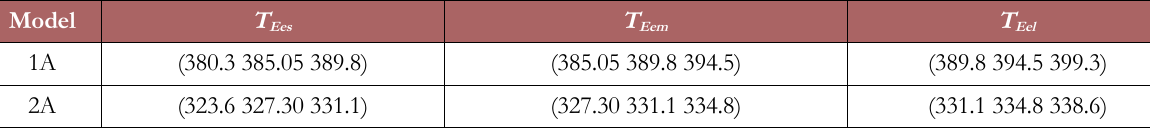
for two bicycle models Ee